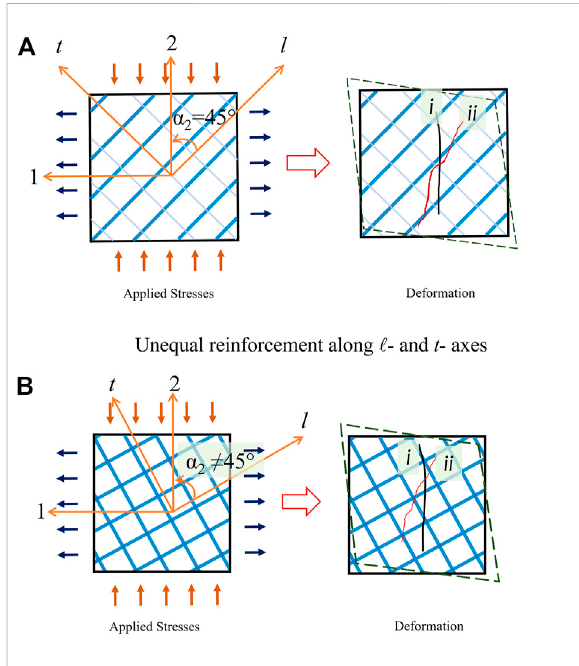
FIGURE 3 Cases of asymmetry in membrane elements. (A) Unequal reinforcement along ℓ - and t- axes. (B) Asymmetric orientation of reinforcement with respect to 2-1